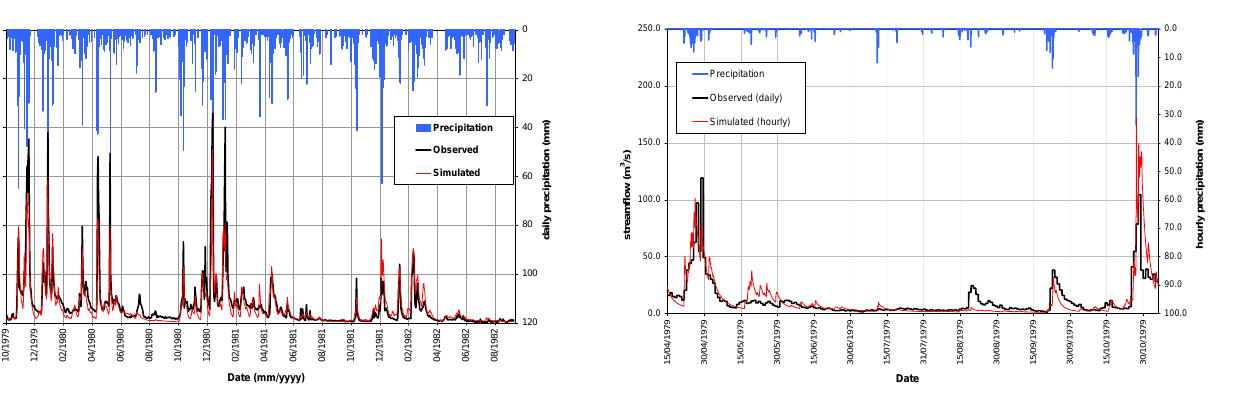
Fig. 6. Daily precipitations and streamflows observed and simulated with TETIS model at Be3 point during the calibration period.